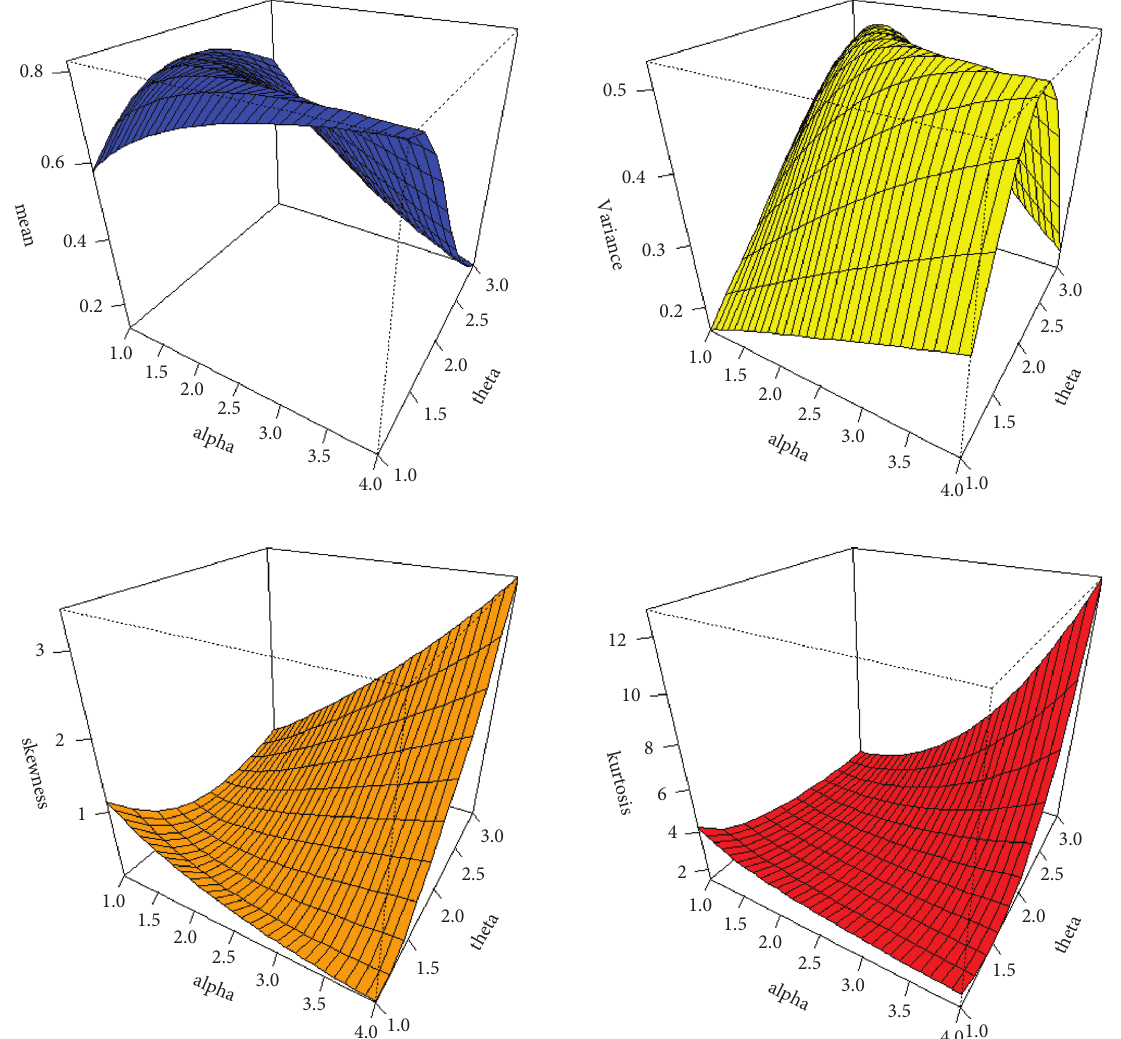
Figure 4: 3D plots of mean, variance, skewness, and